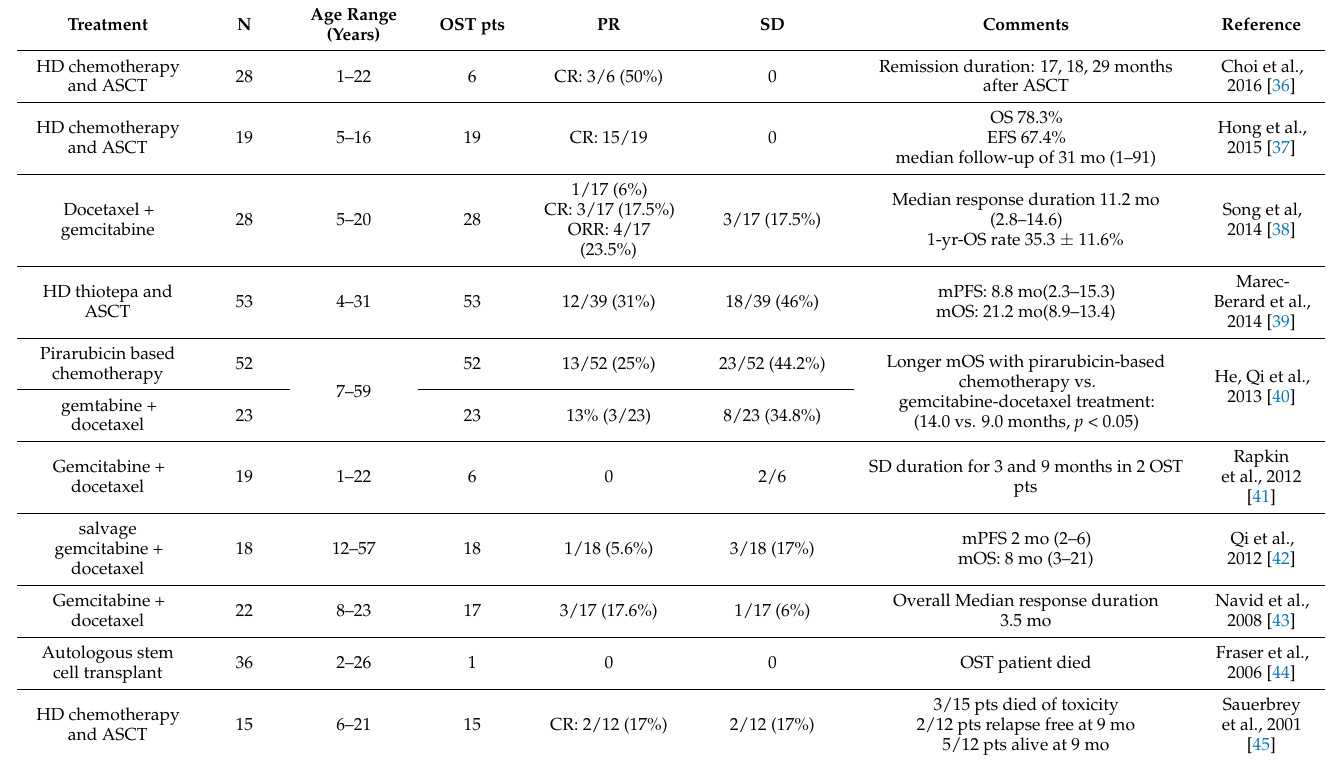
Table 7. Retrospective data (10